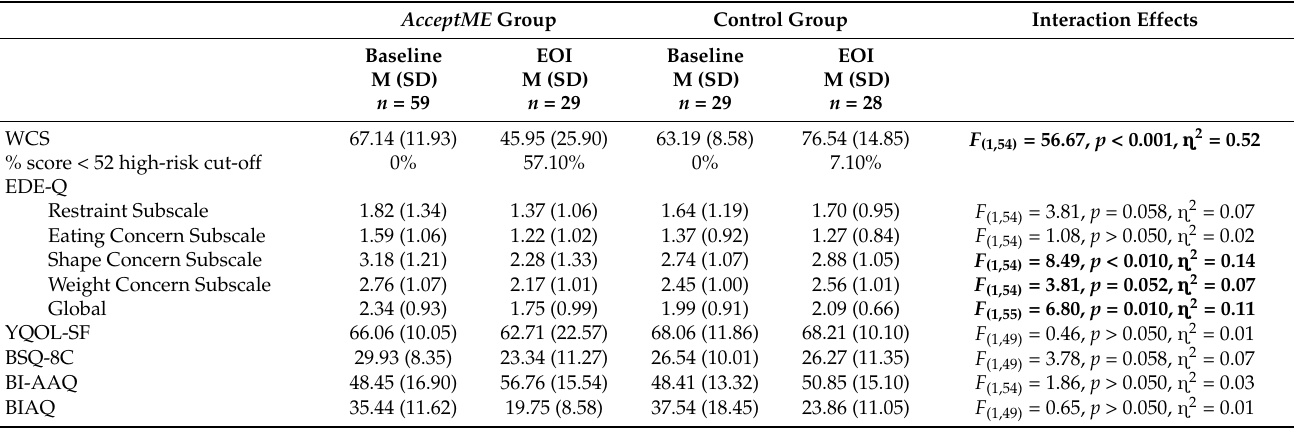
Table 1. Means and standard deviations of outcome at baseline and end-of-intervention by group ( AcceptME vs. waitlist control).